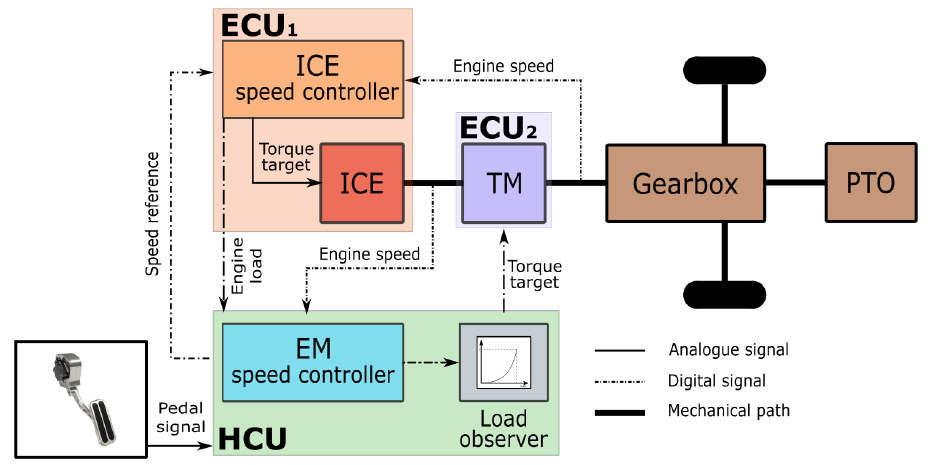
Figure 5. Master–slave control strategy with engine Load